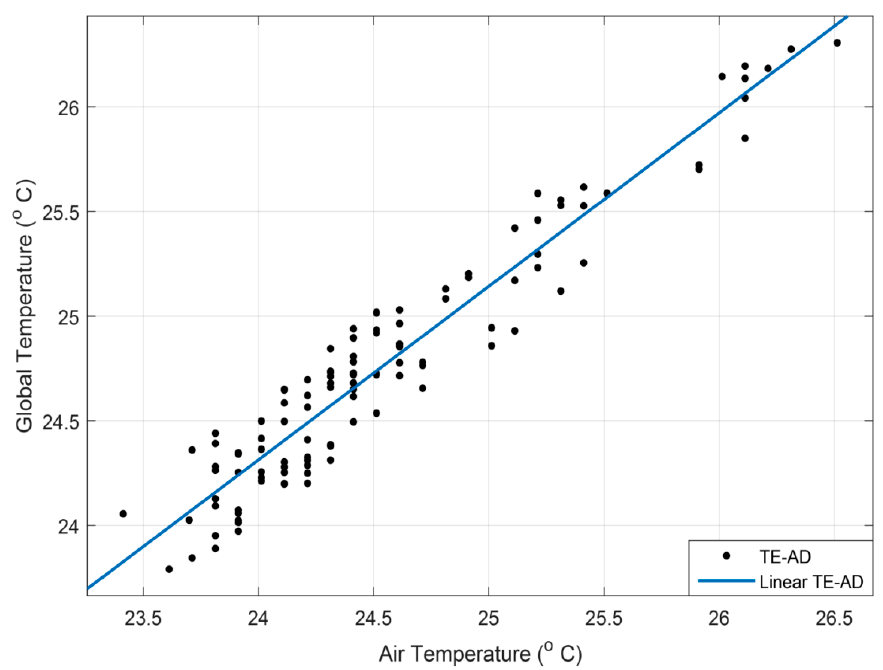
Figure 18. Linear regression between global and air temperatures.